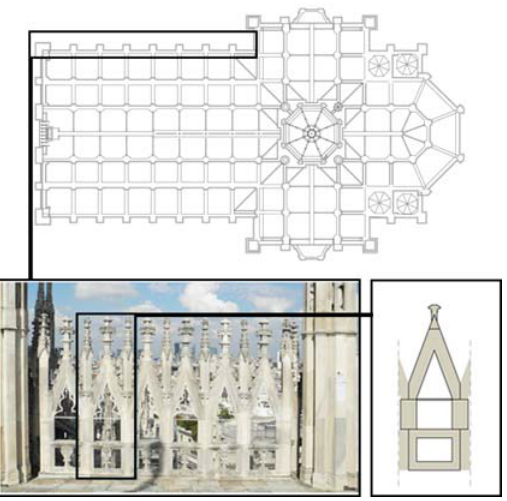
Table 1. Summary of point cloud’s import process in